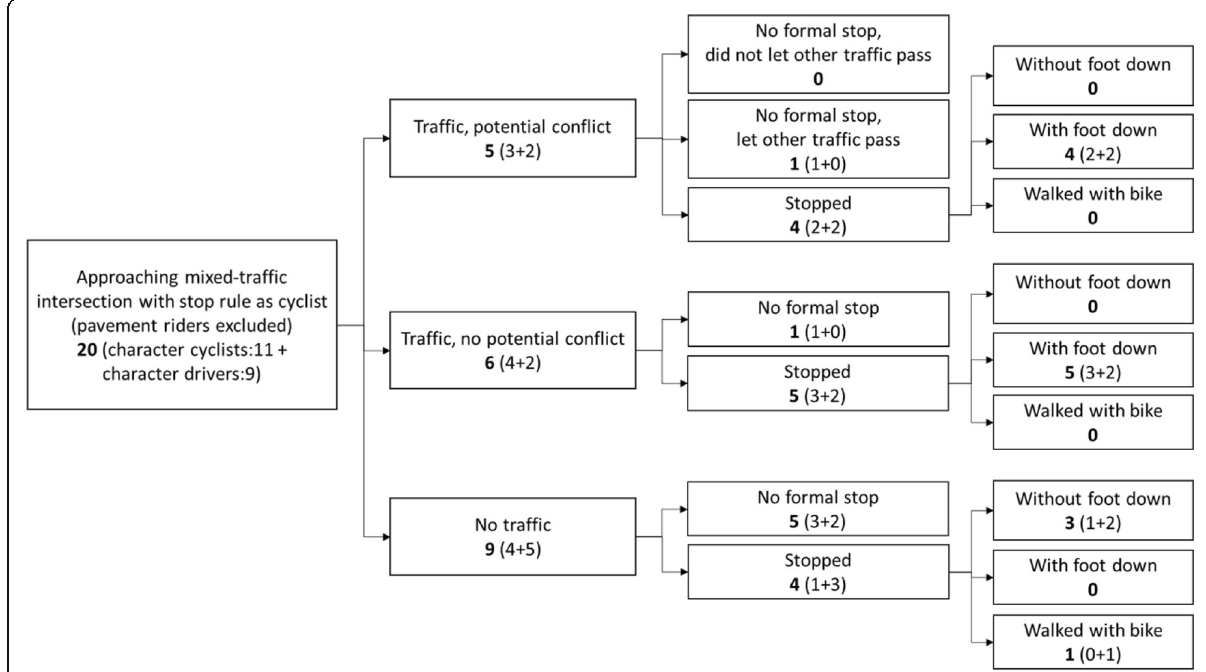
Fig. 3 Actions when cycling in mixed traffic at the intersection with stop rule. Results in total (number of outcomes for character cyclists + number of outcomes for character